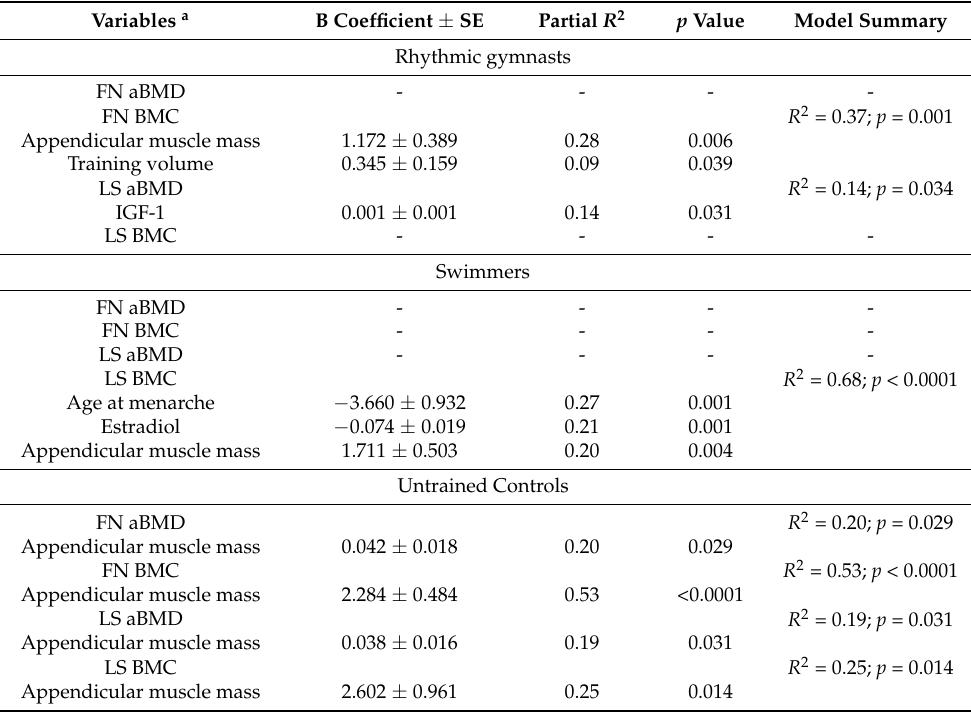
Multiple regression models revealed that IGF-1 was the predictor of bone mineral values only in the RG group and explained 14% of the variance (R 2 × 100) in LS aBMD ( p = 0.031) (Table 3), while the strongest predictor for FN BMC was appendicular muscle mass (by 28%; p = 0.006) followed by training volume (by 9%; p = 0.039) in the RG group. In the SW group, the strongest predictor for LS BMC was age at menarche (by 27%; p = 0.001), followed by estradiol (by 21%; p = 0.001) and appendicular muscle mass (by 20%; p = 0.004). In the UC group, appendicular muscle mass was the only predictor for FN aBMD (by 20%; p = 0.029), FN BMC (by 53%; p < 0.0001), LS aBMD (19%; p = 0.031) and LS BMC (by 25%; p = 0.014) (Table 3). Table 3.